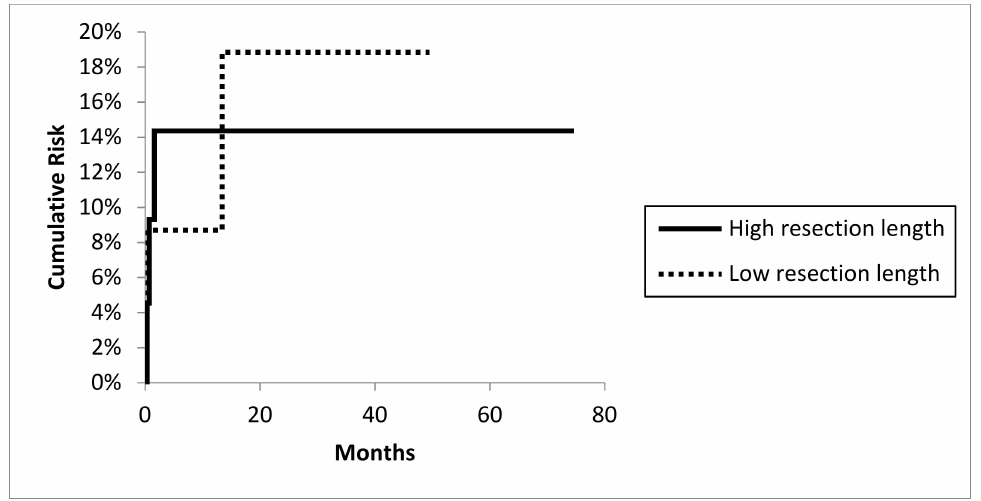
Figure 4. Cumulative risk of dislocation: higher or lower level than medium resection length 14.54 ( ± 4.25 SD; range 7–25) cm and dislocation risk (log-rank p =